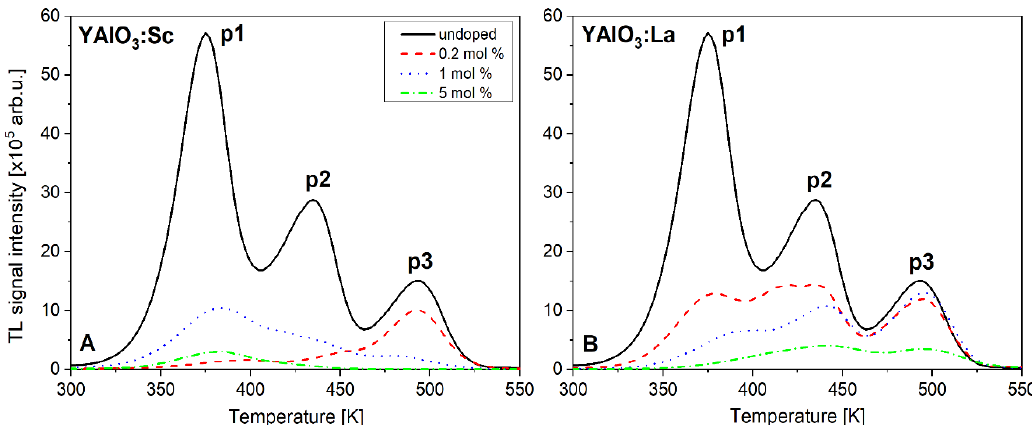
Figure 4. The comparison of thermoluminescence (TL) glow-curve shapes of YAlO 3 :Sc ( A ) and YAlO 3 :La ( B ), with different dopant concentration. The TL glow-curves of the undoped YAlO 3 are also shown.